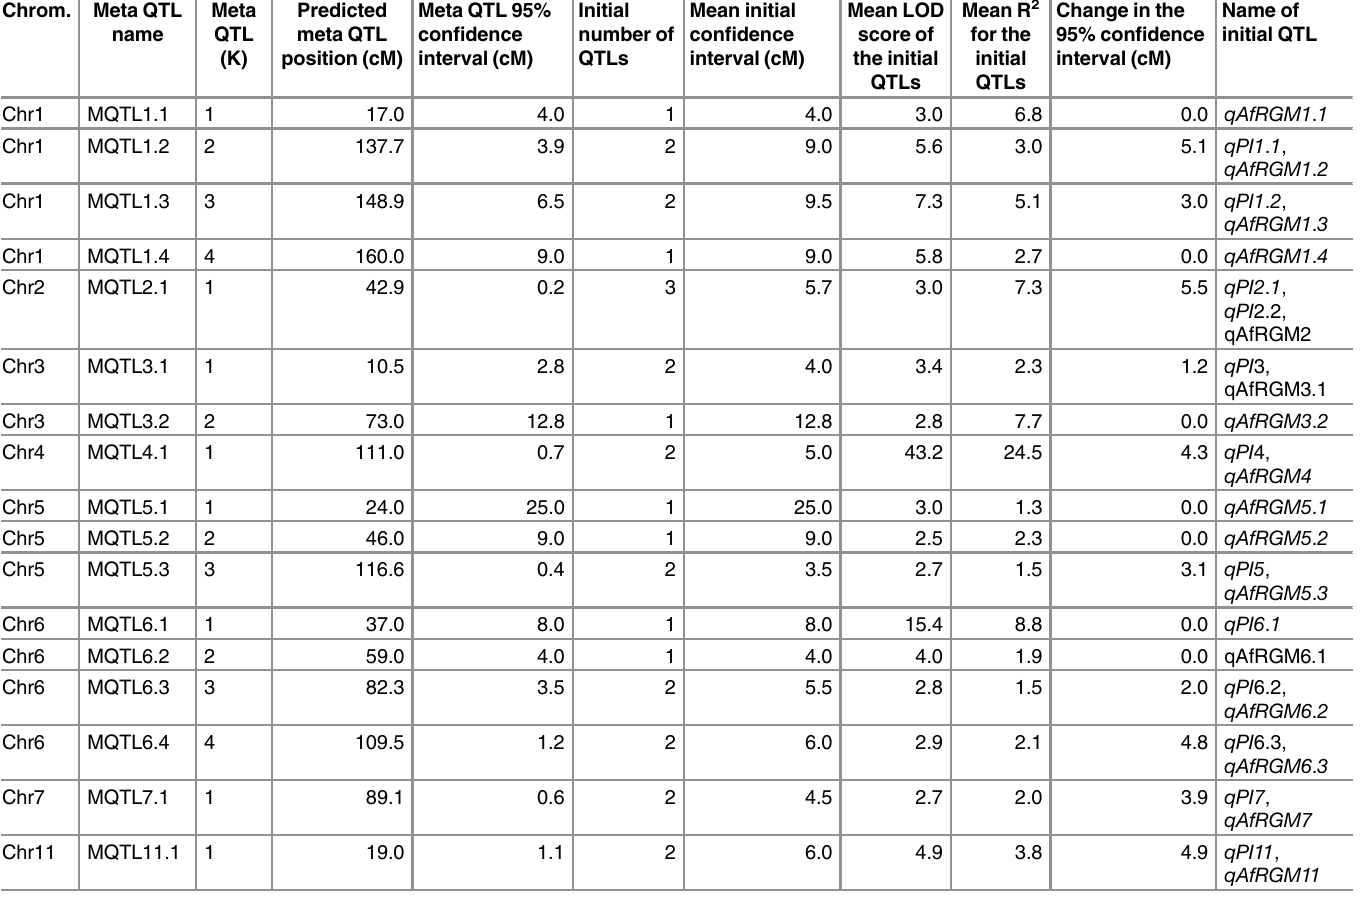
Table 2. Summary of the 17 meta QTLs associated with pest incidence and pest severity across three populations. See Table 1 for details on individ- ual